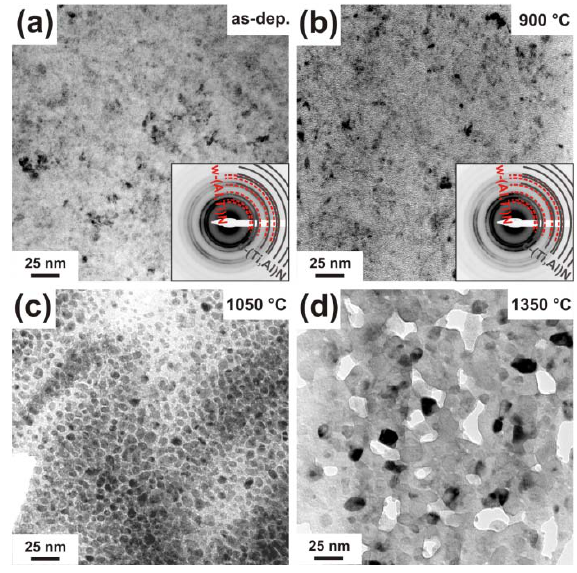
Figure 9. Plan view TEM micrographs of binary c/w-Ti deposited state, and after annealing to (b) 900 °C, (c) 1050 °C, and (d) 1350 °C. The small insets in (a) and (b) are the corresponding SAED